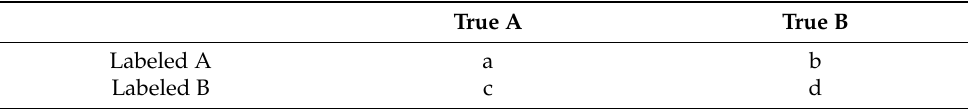
Table 1. Binary classification confusion